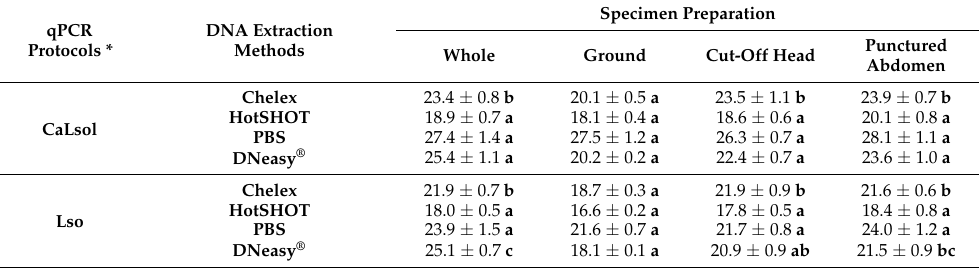
Table 6. CaLsol detection analysis in four specimen preparations and four DNA extraction methods by two qPCR protocols. Specimen Preparation qPCR DNA Extraction Protocols * Methods Whole Ground Cut-Off Head Punctured Abdomen CaLsol